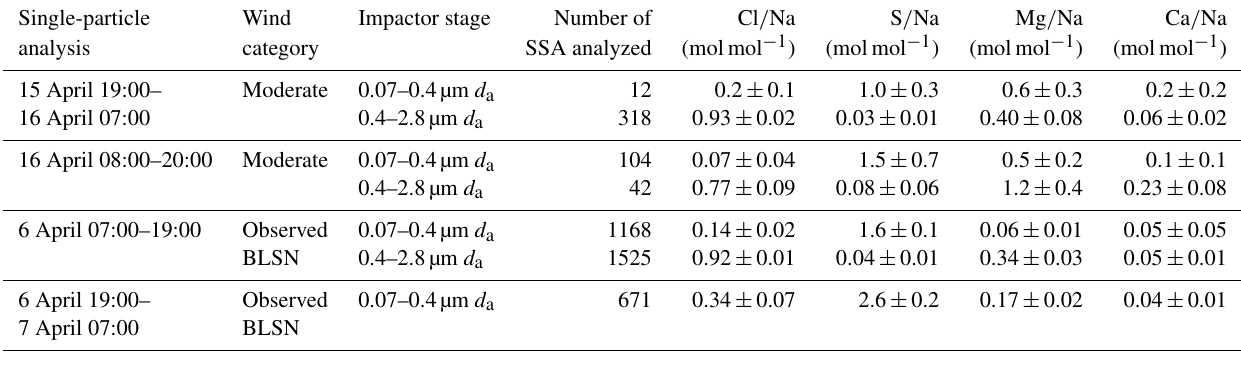
Table 3. Single-particle elemental ratios (average ± 95% confidence intervals) of sea spray aerosol (SSA) particles identified by CCSEM- EDX during (a) two moderate wind periods (15 April 19:00–16 April 07:00 and 16 April 08:00–20:00) and (b) two observed blowing snow periods (6 April 07:00–19:00 AKDT and 6 April 19:00–7 April 07:00). Wind categories, particle diameters, and numbers of SSA particles